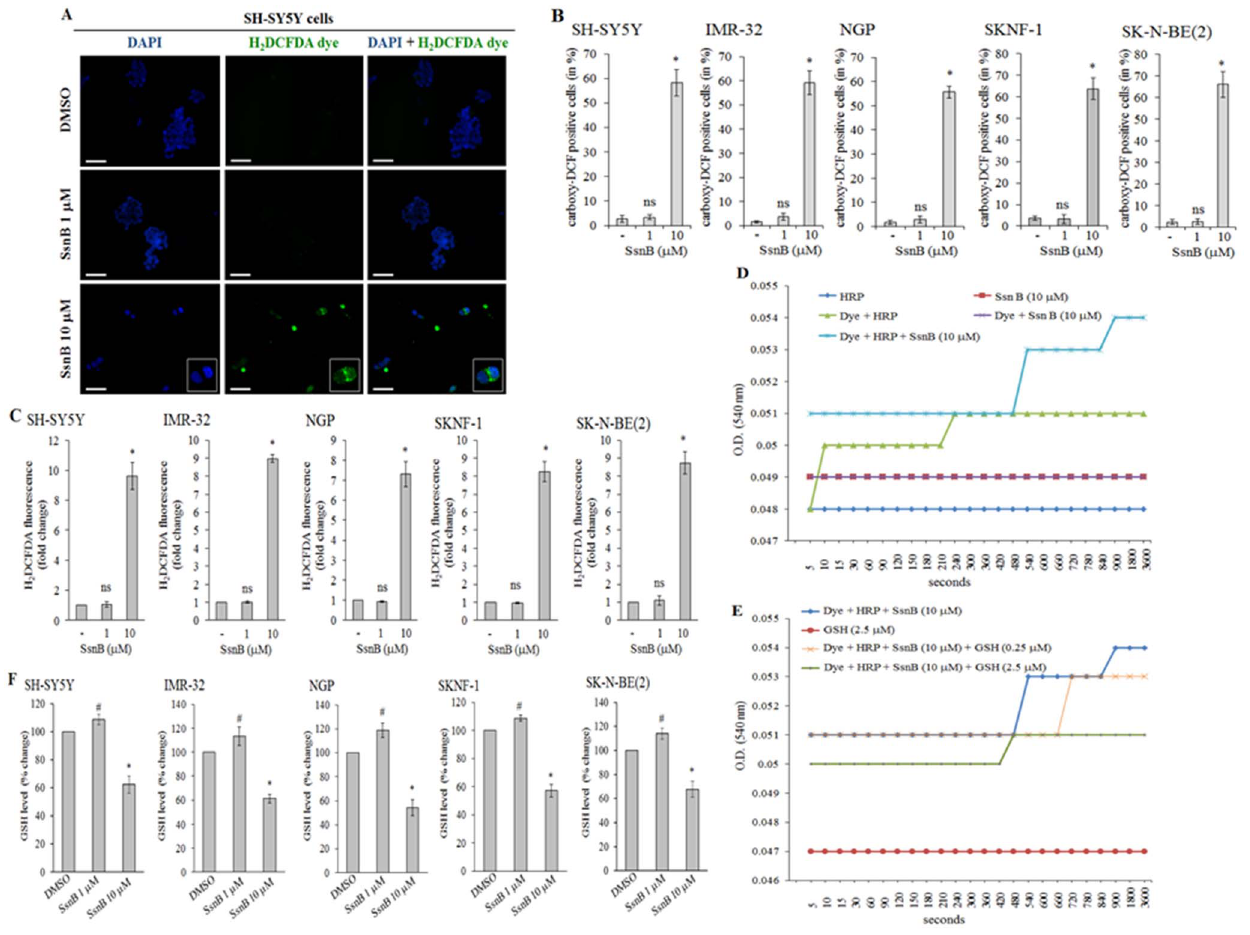
Figure 2. SsnB induces reactive oxygen species (ROS) generation. ROS levels were evaluated by H 2 DCFDA staining after SsnB treatments (1 m M or 10 m M) for 2 days (SH-SY5Y, IMR-32), 3 days (NGP) or 4 days (SKNF-1 and SK-N-BE(2) cells). Signals were examined under fluorescence microscope ( A ); carboxy-DCF positive cells (green) were quantitated by ImageJ programme and plotted ( B ). ( A ) Representative fluorescence images from SH-SY5Y cells showing that compared to DMSO and SsnB (1 m M), SsnB at 10 m M concentration induced ROS generation (green, H 2 DCFDA- positive cells) and signals were exclusively present in cytoplasm (as shown in enlarged images). Nuclei were counterstained with DAPI (blue). Images are representative of at least three independent experiments. Scale bar=100 m m. ( C ) Bar diagrams representing the fold change in fluorescence intensity of H 2 DCFDA in cells treated with or without SsnB (1 m M or 10 m M) as mentioned above. After labelling with H 2 DCFDA dye (25 m M) for 30 min fluorescence intensity was monitored at excitation wavelength 485 nm and emission wavelength 530 nm. Values are mean and S.D. of three experiments. * p , 0.05, SsnB 10 m M vs control; ns = nonsignificant vs control. ( D and E ) ROS generating capacity of SsnB was also evaluated in cell- free system containing